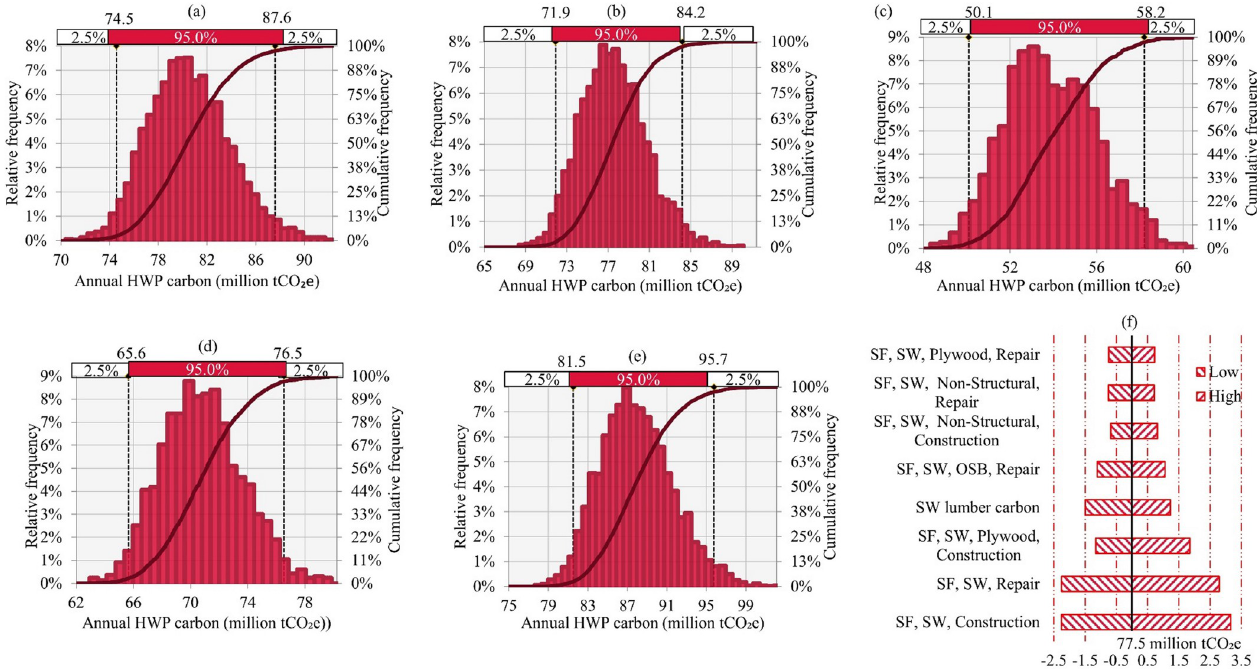
Fig 6. Probability distribution (as histogram and cumulative) of annual wood products carbon stored in residential units in use and in landfills, 2015–2070, for SSP 1–5 (a, b, c, d, and e, respectively) and the impact of critical input parameters on the estimated average annual wood products carbon in SSP2 (f).